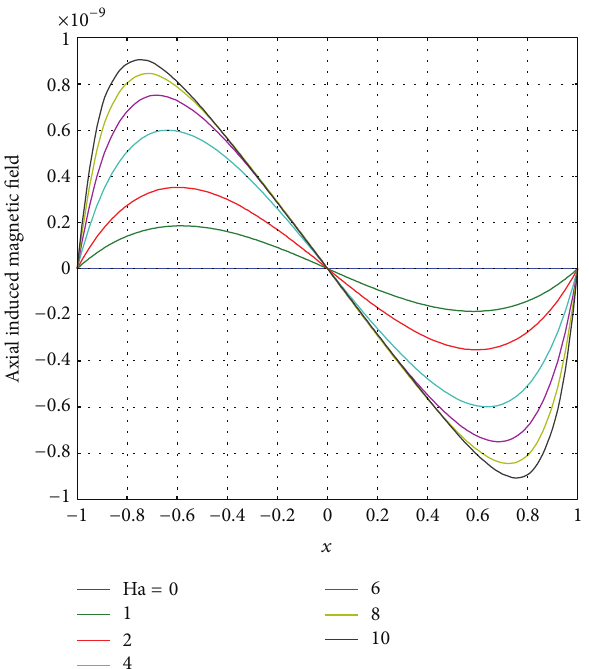
Figure 14: Axial induced magnetic field profiles with different time in a period (6th cycle) for Re = 100 , 𝛼 = 5 and Ha = 2